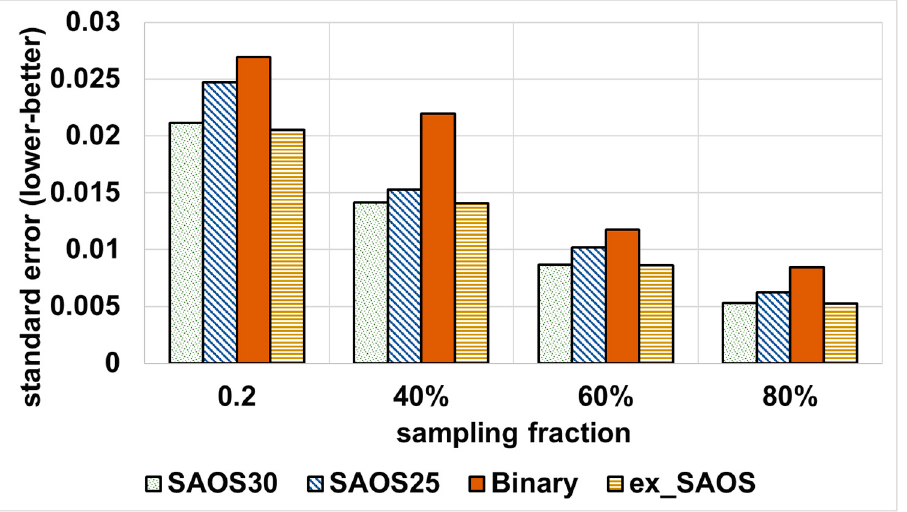
Figure 6. Standard error achieved by all systems, including ApproxSSPS: ‘computing the average speed in Shenzhen mobility data’. Generally, ex-SAOS and SAOS at geohash precision 30 achieve the lowest standard error. SAOS at geohash 25, instead, achieves a higher standard error, which, however, remains lower than that of the baseline.